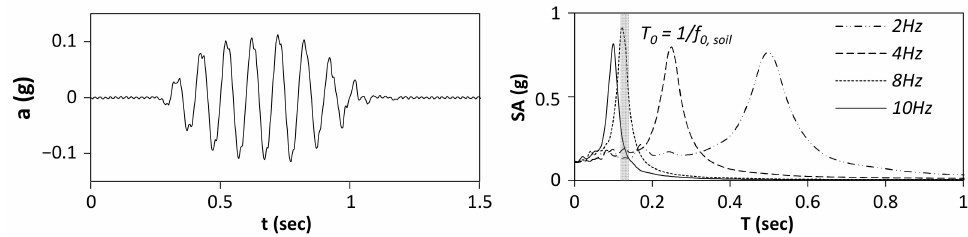
Figure 8. Seismic excitations used in the shaking table tests, with a peak ground acceleration (PGA) of 0.1 g.